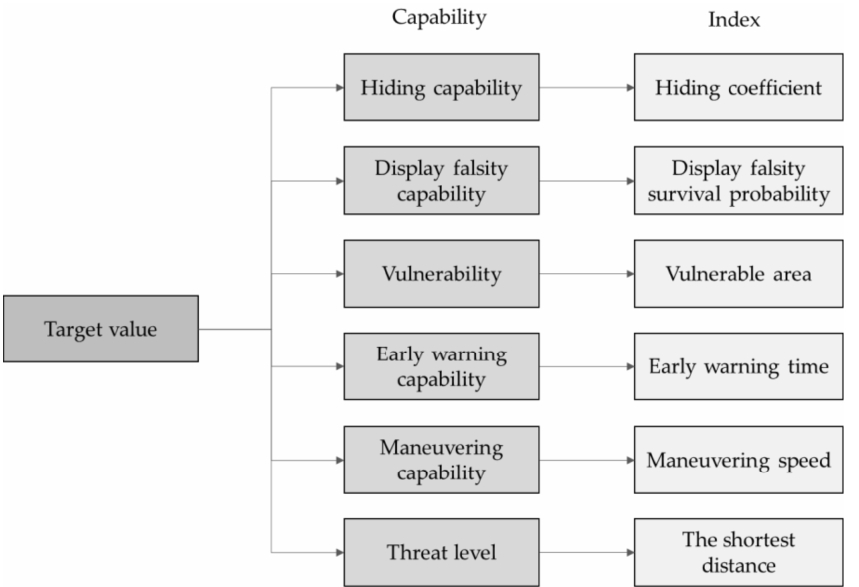
Figure 2. Target value evaluation index system.